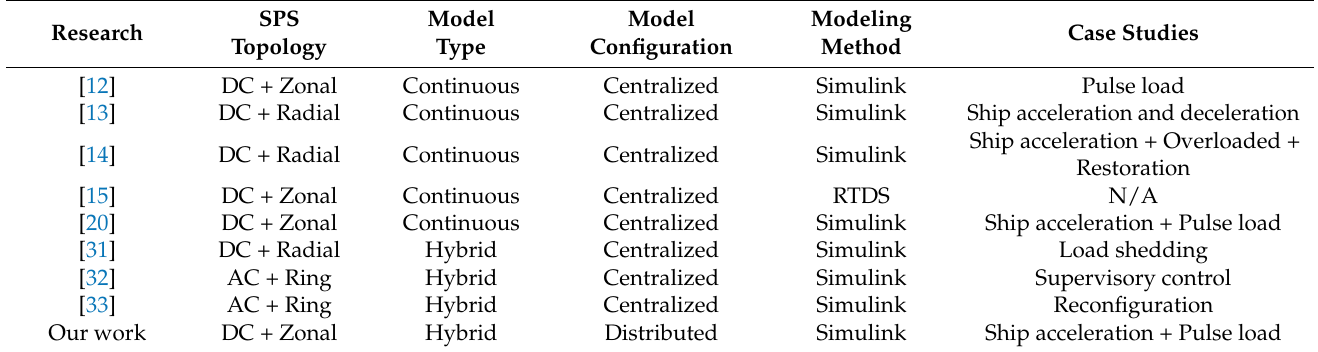
Table 5. Comparison of different modeling